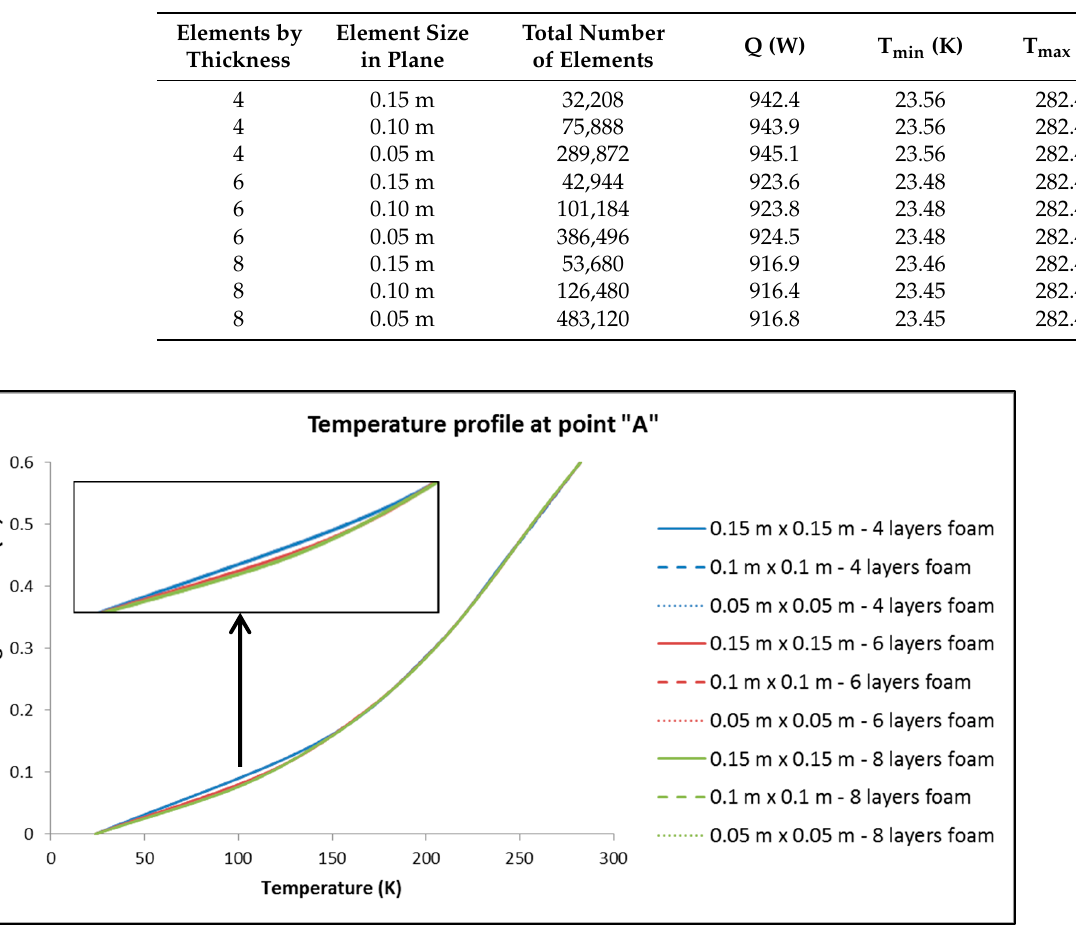
Figure 6. Temperature profile through the insulation thickness at point “A” of Figure 5.